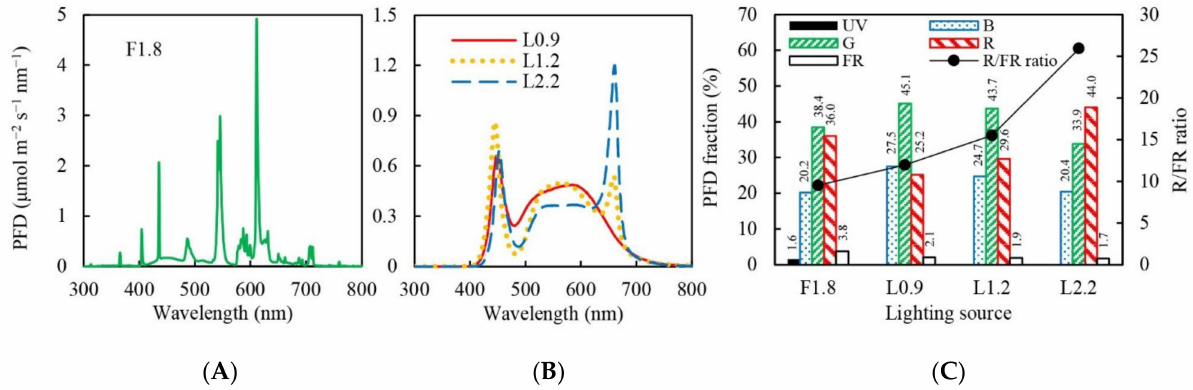
Figure 2. Spectral distribution of photon flux density (PFD) emitted by fluorescent lights (F1.8) with R:B ratio of 1.8 ( A ) and three LED lights (L0.9, L1.2 and L2.2) with R:B ratio of 0.9, 1.2 and 2.2, respectively ( B ). The total PFD was normalized to 100 µ mol m − 2 s − 1 . The PFD of ultraviolet light (UV, 300–399 nm), blue light (B, 400–499 nm), green light (G, 500–599 nm), red light (R, 600–699 nm) and far-red light (FR, 700–800 nm) were obtained by integral calculation ( C